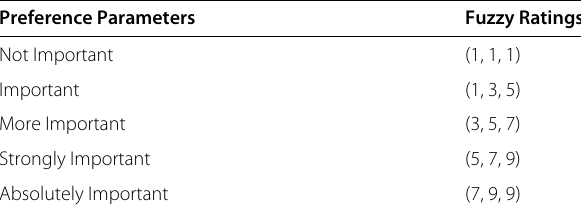
Table 2 Preference Parameters with Fuzzy Ratings Preference Parameters Fuzzy Ratings